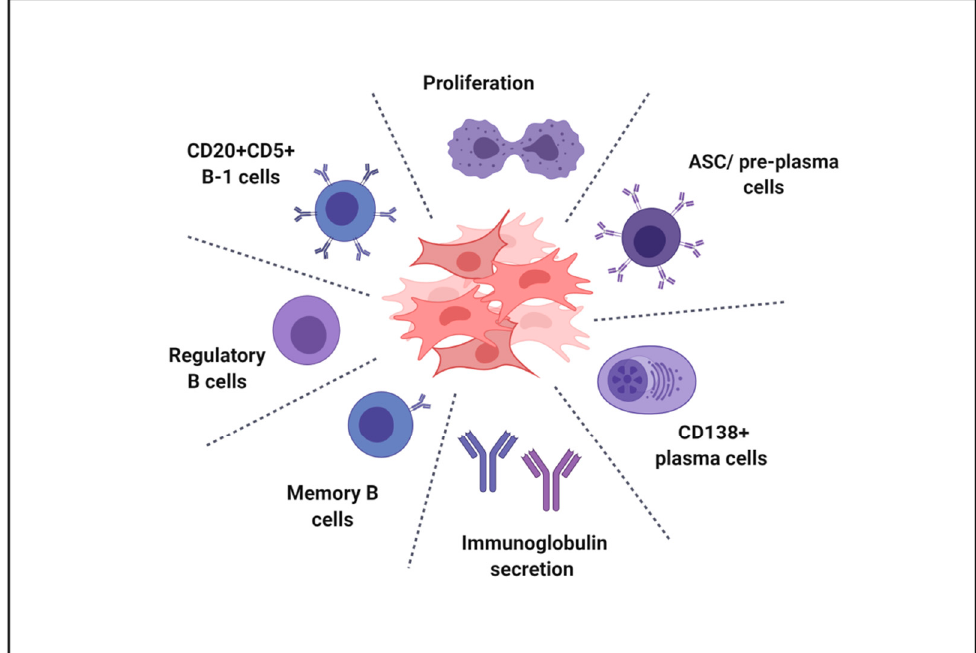
Figure 2. B cell targets of perinatal cells. In vitro and in vivo studies have shown that perinatal cells affect B cell proliferation and immunoglobulin secretion. Moreover, perinatal cells influence the differentiation of diverse B cell subsets (antibodies secreting cells, plasma cells, regulatory B cells, memory B cells, B-1a cells). ASC, antibody-secreting cells. Created with BioRender.com (accessed on 21 February